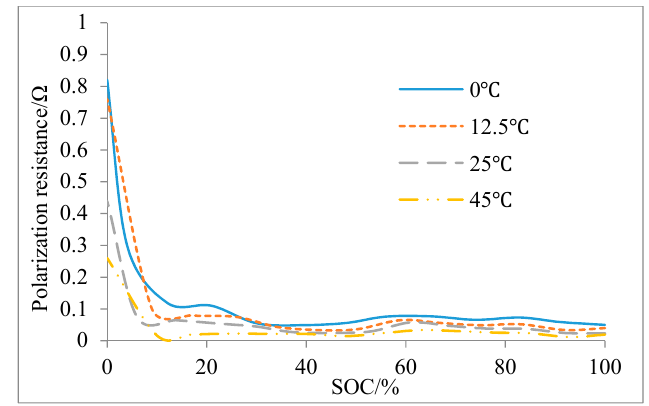
Figure 8. Polarization resistance at different temperatures, SOCs.